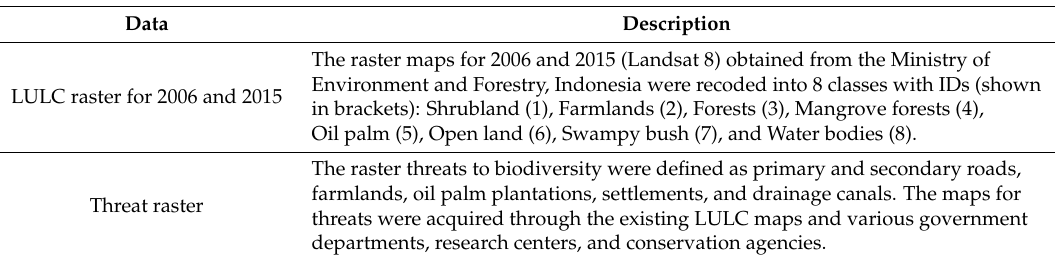
Table A1. Data source and